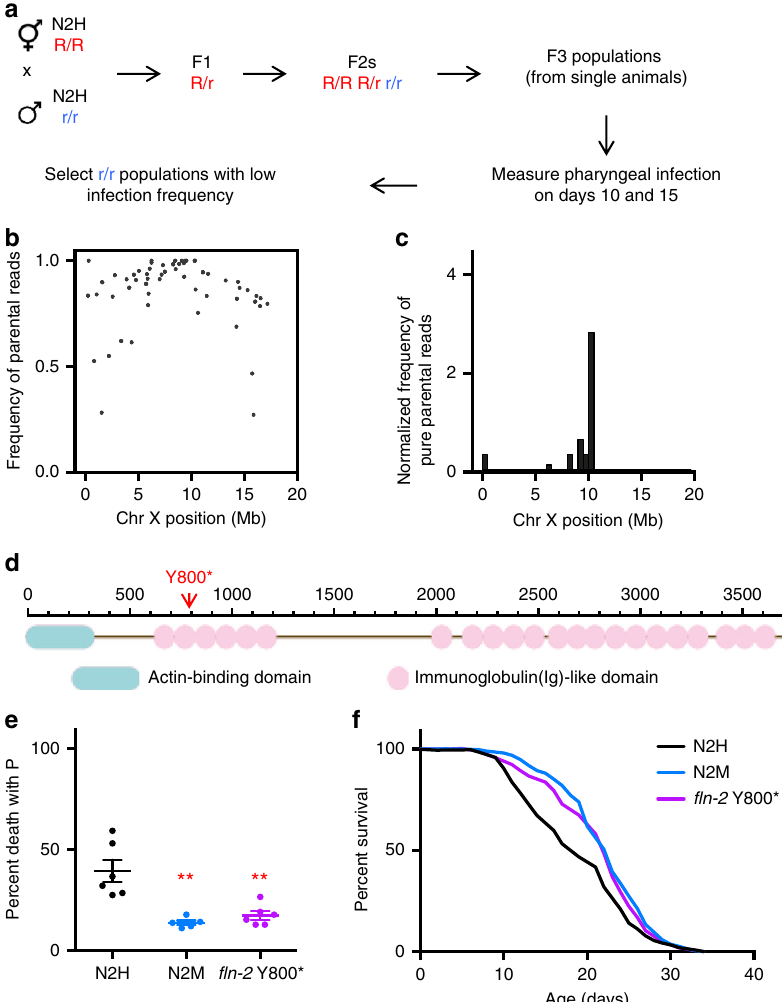
Fig. 2 Resistance to P death is caused by a recessive mutation in fl n-2 . a Design of Variant Discovery Mapping strategy to select the recessive low P phenotype of N2M in F3 progeny. b Frequency of parental (N2M genotype) reads on chromosome X. For results for all chromosomes see Supplementary Fig. 3. c Normalised frequency of pure parental (N2M genotype) reads on chromosome X. d Illustration of the fl n-2(ot611) mutation on FLN-2A, the longest isoform of fl n-2 . e Necropsy analysis and f lifespan of N2H-derived fl n-2(syb202) Y800* strain. N2H survival curve in black, N2M in blue, and fl n-2 Y800* in purple. Asterisks indicate p < 0.01, Student ’ s t test. Error bars represent s.e.m. of three trials. See Supplementary Table 2 for full statistics. See Supplementary data 1 for raw mortality data. Source data are provided as a Source Data fi